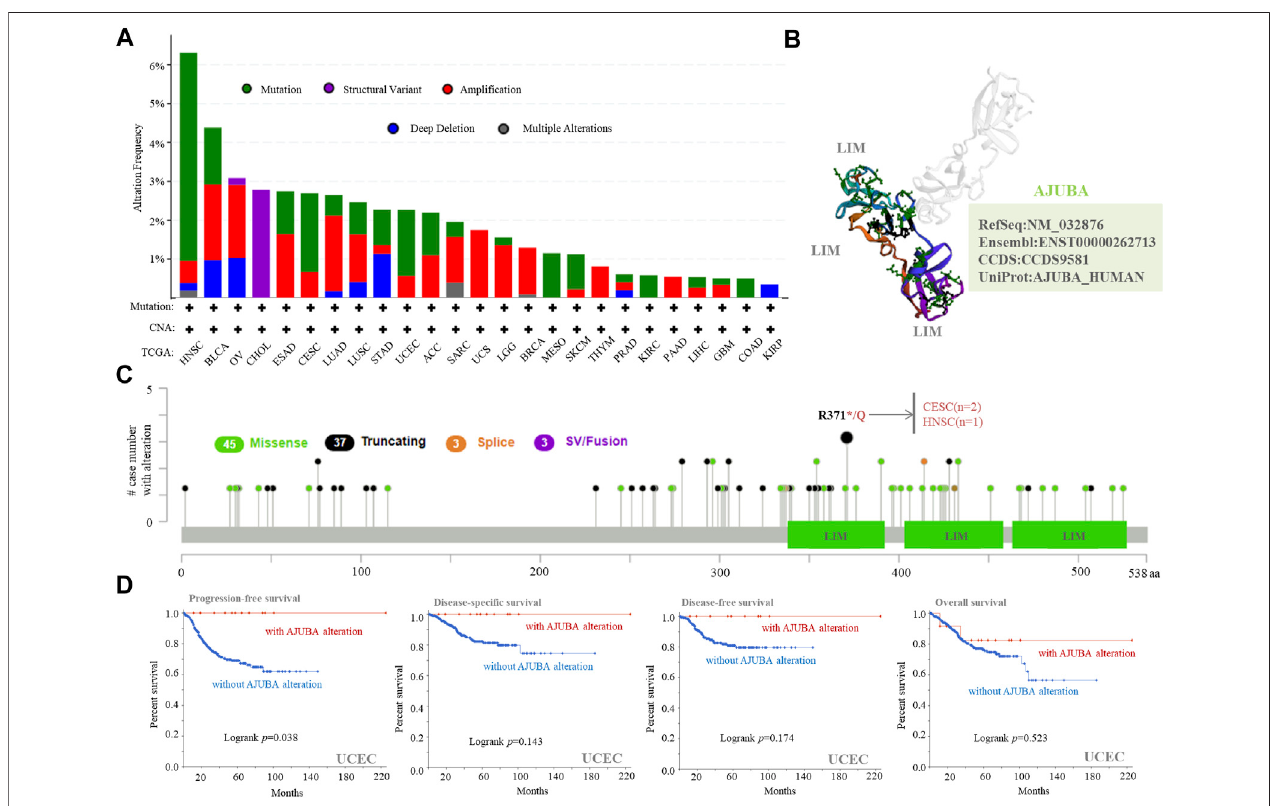
FIGURE5| Mutation feature ofAJUBA indifferentcancersofTCGA.ThemutationfeaturesofAJUBAamongtheTCGA tumorswasanalyzed using thecBioPortal tool. The alteration frequency with (A) mutation type, (B) the 3D structure of AJUBA protein, and (C) mutation sites are displayed. (D) Using the cBioPortal tool, we analyzed the potential relationship between mutation pro fi les and progression-free, disease-speci fi c, disease-free, and overall survivals of UCEC.